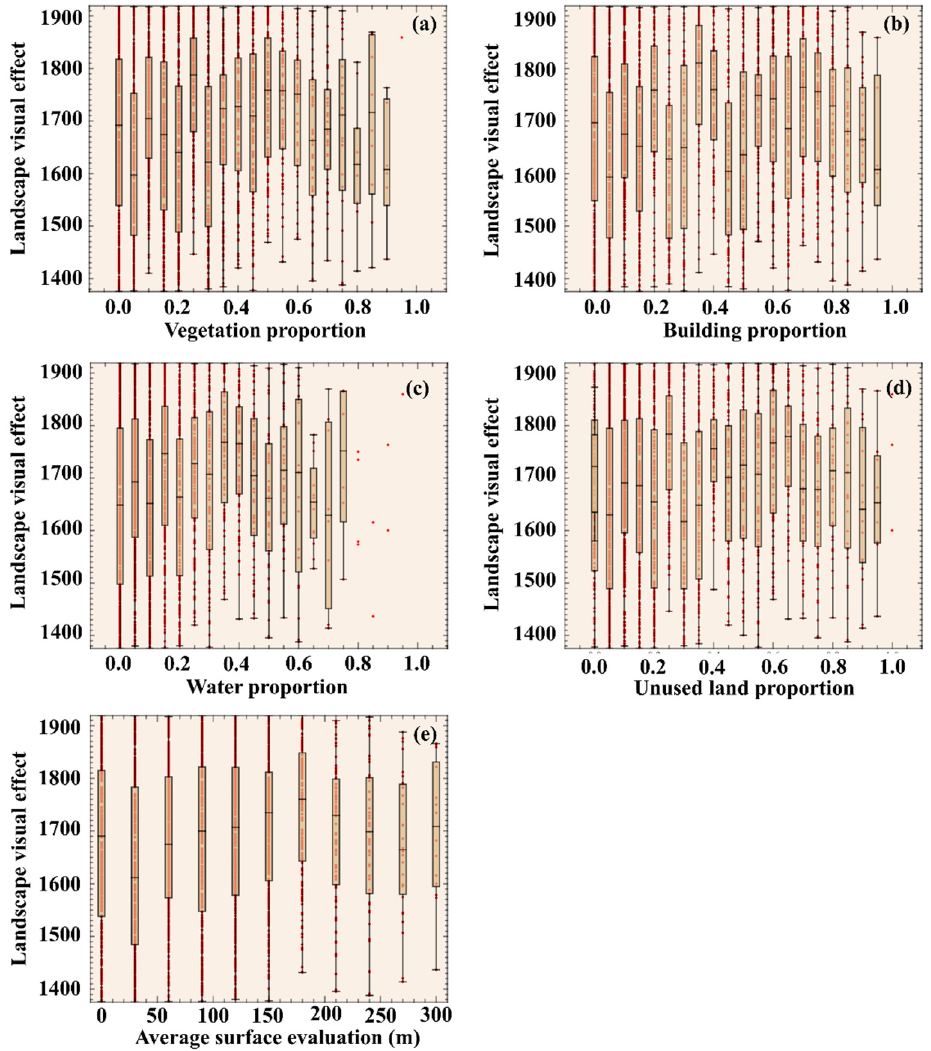
Figure 9. Box plots of 5 factors with landscape visual effect. ( a ), ( b ), ( c ), ( d ), and ( e ) are the simulated relationships between landscape visual effect with vegetation proportion, building proportion, water proportion, unused land proportion, and average surface evaluation, respectively.